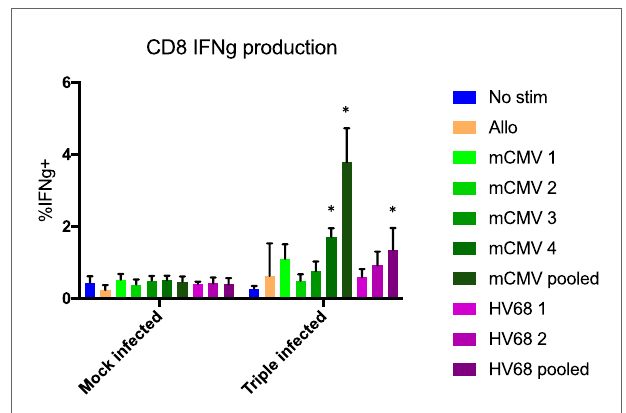
FigUre 7 | No difference in interferon gamma (IFNg) production was observed in response to any stimulation condition in mock-infected mice. CD44 + CD8 T cells from mice that received all three infections produced IFNg in response to viral peptides, with the highest level of IFNg production in response to pooled peptides. No significant difference in IFNg production between mock- and triple-infected mice in the presence of no stim or allogeneic antigen, but significant increases in triple-infected mice compared with mock-infected mice were observed in the presence of a single or pooled murine cytomegalovirus (mCMV) peptides ( p < 0.001, calculated using two-way ANOVA), and pooled HV68 peptides ( p = 0.0013, calculated using two-way ANOVA), n = 5 per